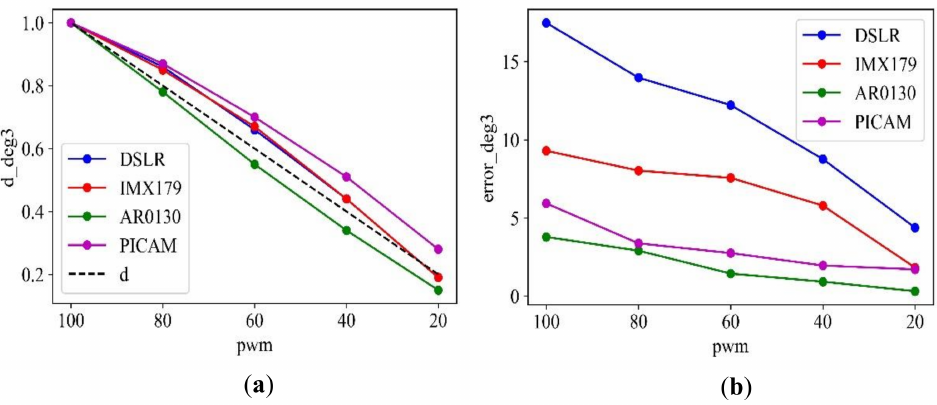
Figure 9. Comparison of the 3rd parameter for PWM 100 to 20 of each camera: ( a ) constant; ( b ) error.